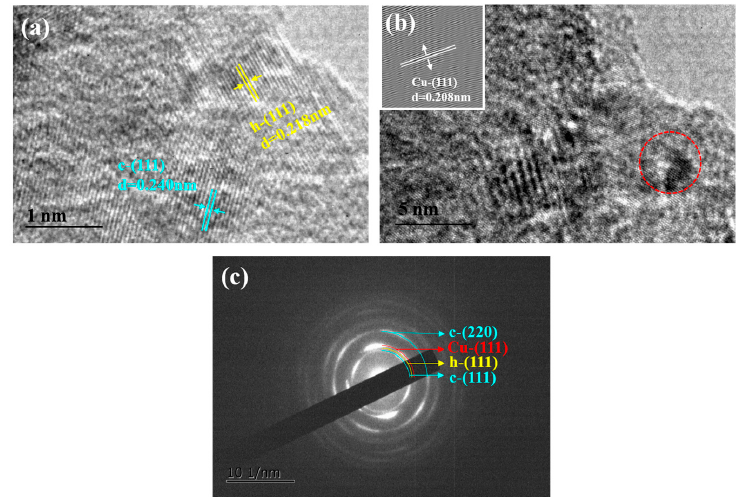
Figure 3. ( a ) Selected area electron diffraction (SAED) pattern and ( b , c ) high resolution transmission electron microscopy (HR-TEM) observations of VCN–1.7 at.% Cu film.